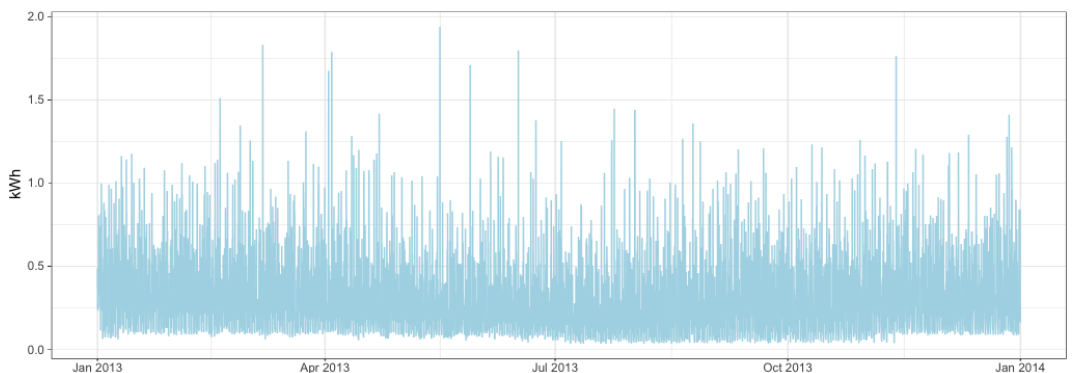
Figure 1. Consumption for smart-meter 18 along 2013.